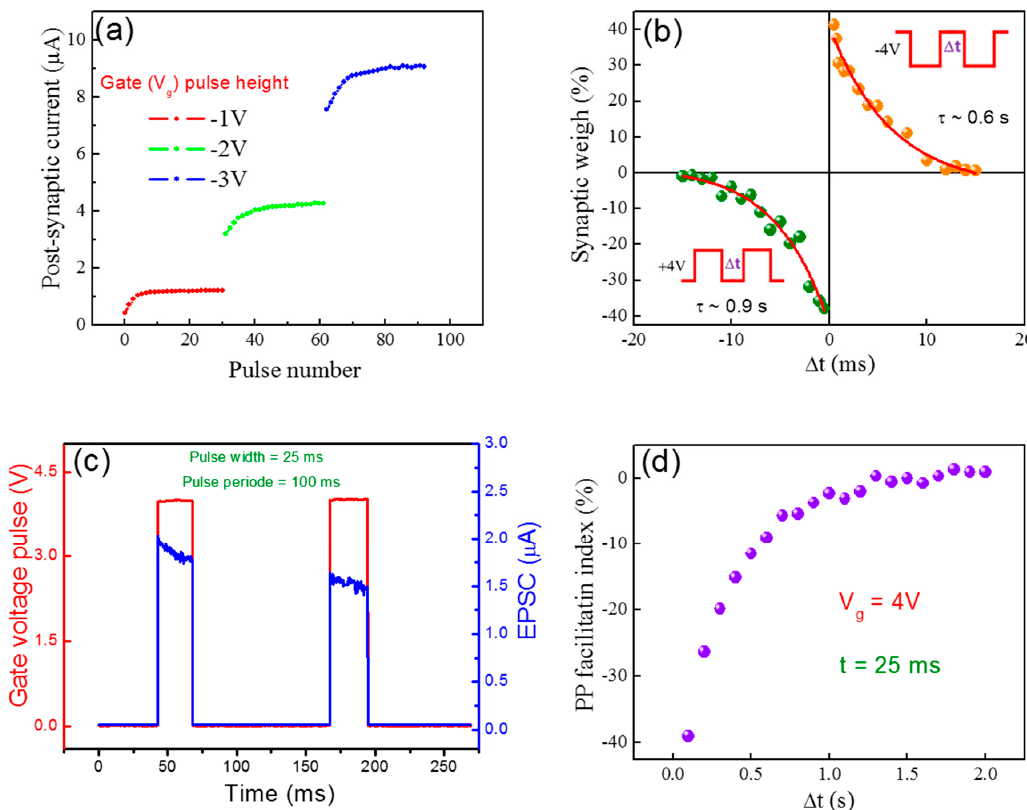
Figure 5. ( a ) Post-synaptic current vs. pulse number at different gate voltage pulse height, mimicking spiking amplitude-dependent plasticity. ( b ) The change in synaptic weight as a function of the time interval ( ∆ t) between paired gate pulses of + 4 and − 4 V. ( c ) The change in EPSC after the application of two closely spaced pulses are applied to the gate terminal. ( d ) Quantification of STP using pulse paired facilitation measurements. Paired pulse facilitation (PPF) index designates the % change in the PSC due to the second pulse.